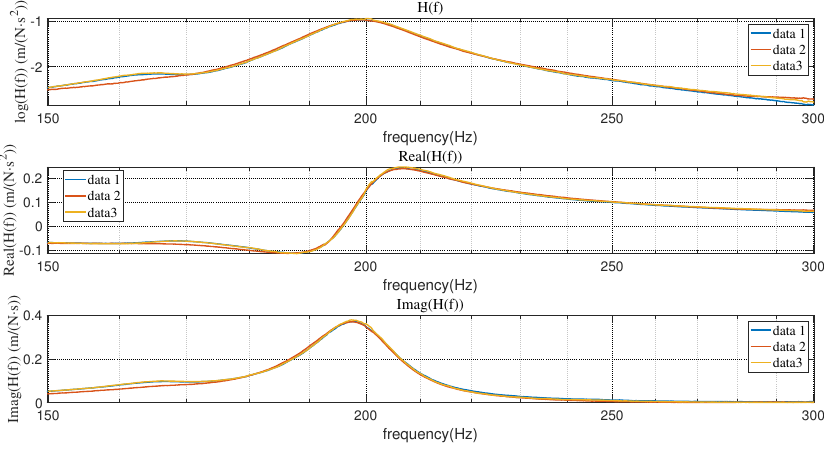
Figure 17. Schematic diagram of multiple groups of experimental data.